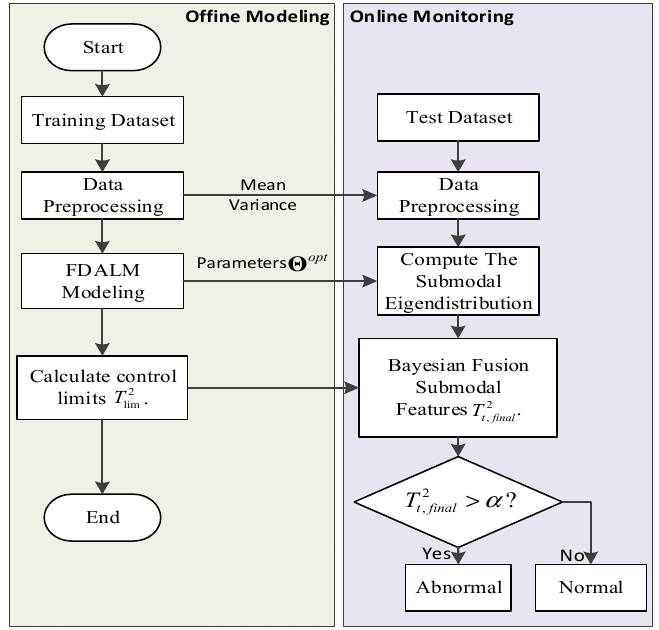
Figure 5. Flow chart of the process monitoring method based on FDALM.